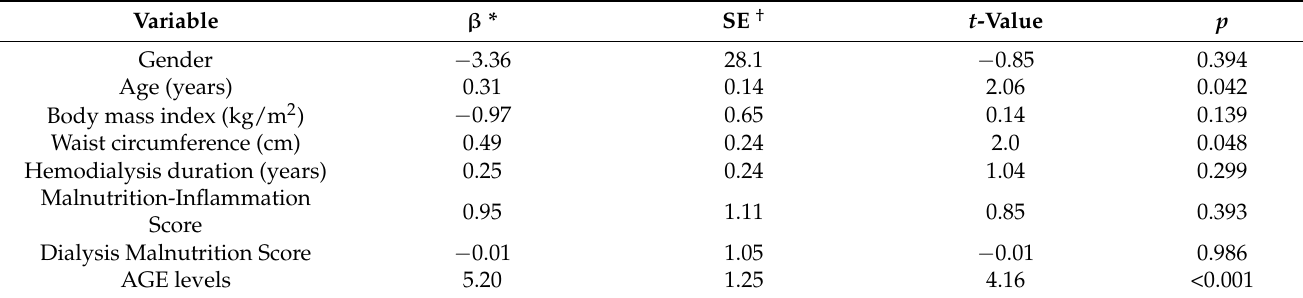
Table 4. Multiple linear regression model of independent predictors for CST concentration.